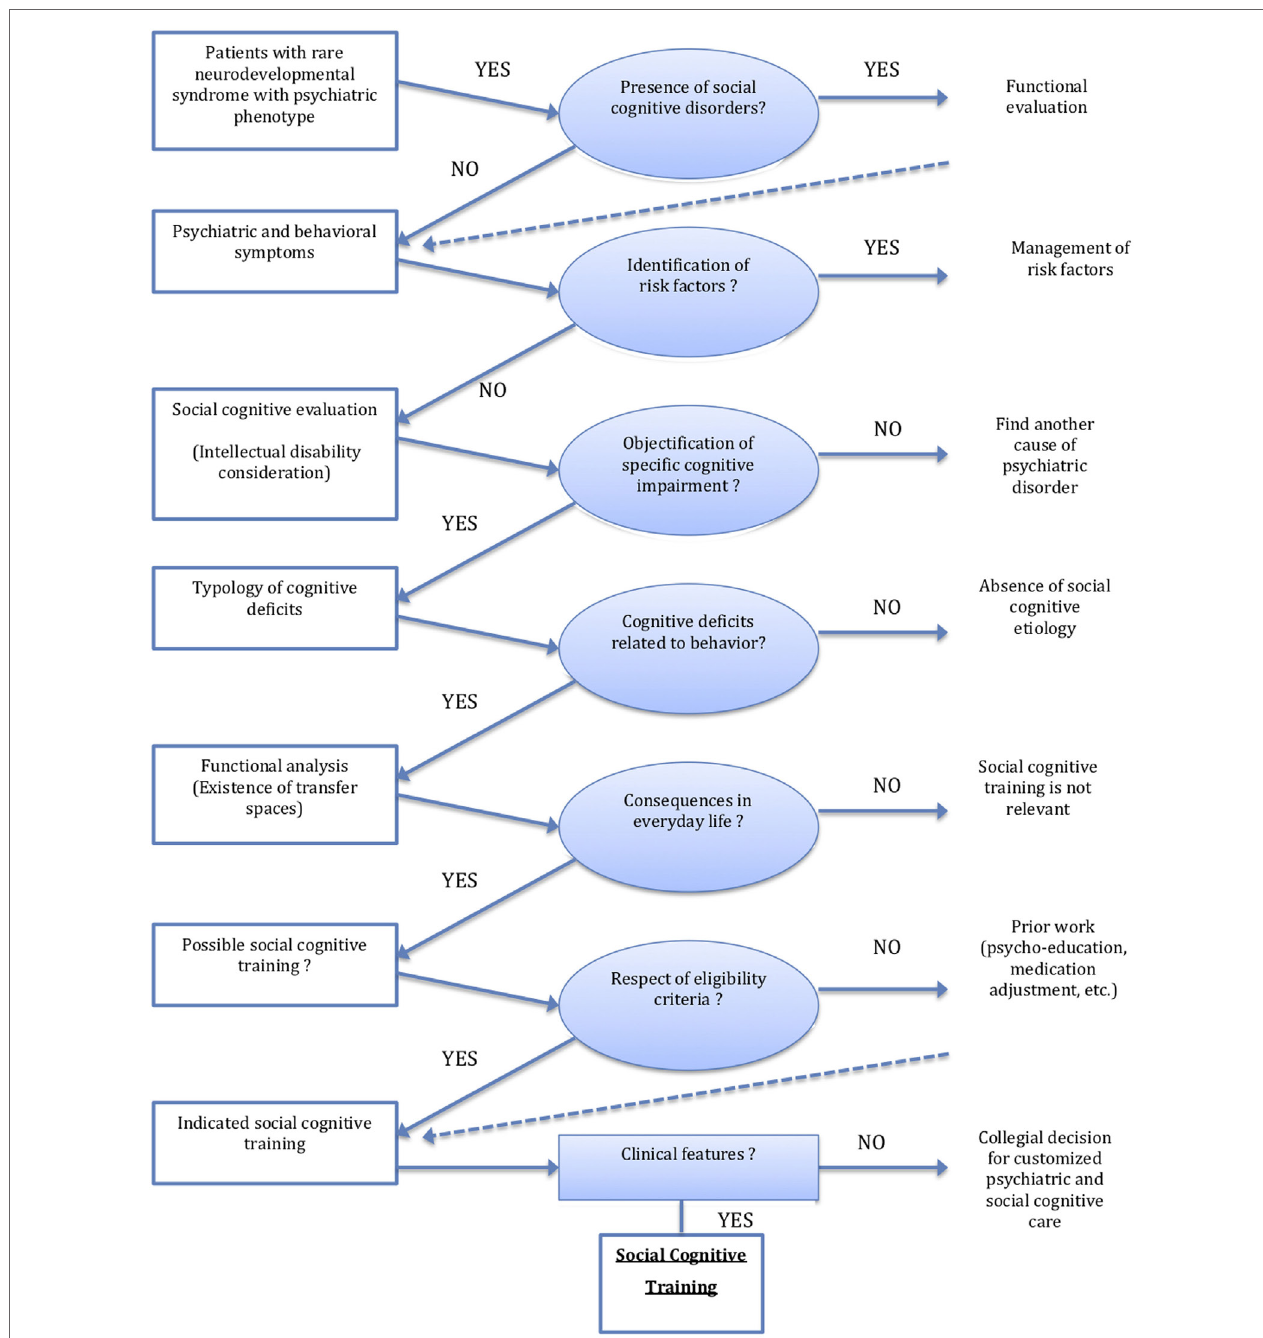
FigURe 1 | Organizational decision chart of social cognitive training in rare neurodevelopmental syndromes with psychiatric phenotype.